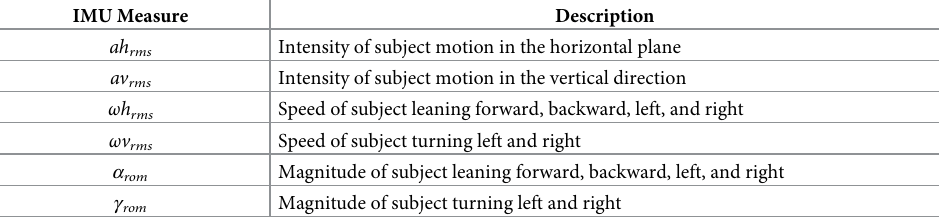
Motion measures capture the full six degree-of-freedom motion of each subject in terms of motion intensity, speed, and magnitude during the Potential Threat, Startle, and Response Modulation temporal threat phases. They include root-mean-squared (rms) translational acceleration in the horizontal plane ( ah ) and vertical direction ( av ), rms rms rms angular velocity in the horizontal plane ( ωh rms ) and vertical direction ( ωv rms ), range of torso tilt motion (rom) relative to the vertical direction ( α ), and range of subject yaw angle ( γ rom rom